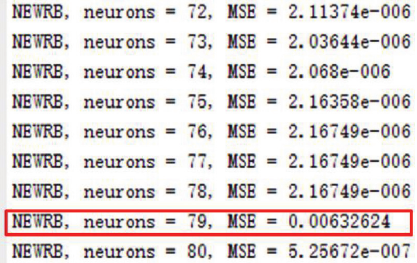
Figure 5: Network training